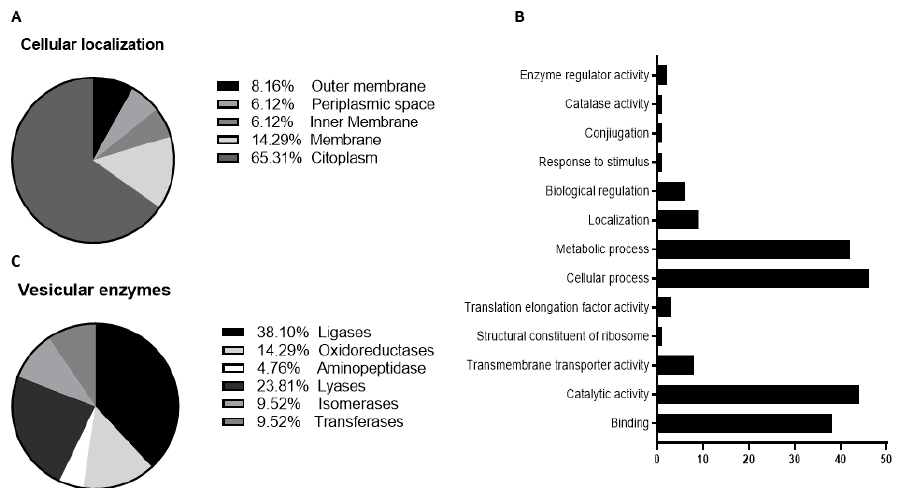
Figure 2. Classification of cellular localization ( A ), functional annotation ( B ) and enzymatic classes ( C ) of protein extracted from K. pneumoniae- OMVs.